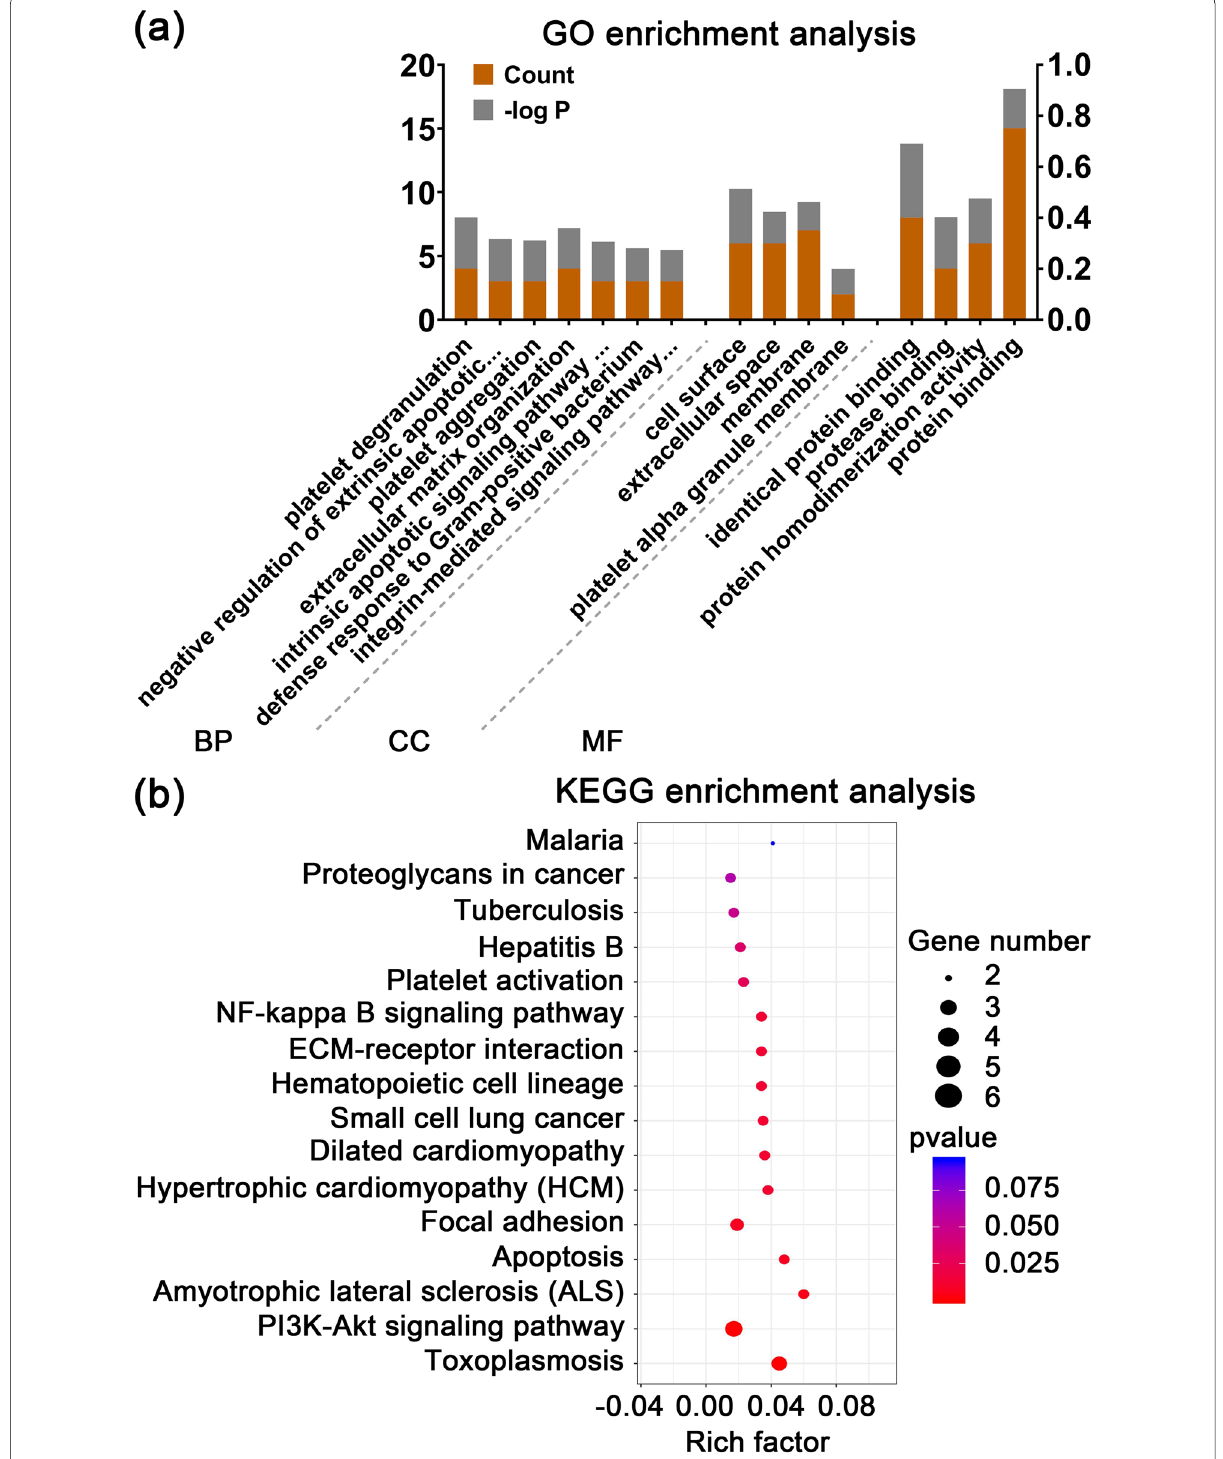
Fig. 5 GO and KEGG enrichment analysis of the core targets of DMAG against thrombocytopenia. a GO enrichment analysis. GO annotations based on the three‑dimension terms of biological process (BP), molecular function (MF), and cellular component (CC). The orange histogram reflects the magnitude of the p value (expressed as log p). The gray histogram shows the number of genes. b KEGG pathway enrichment analysis for − the mechanisms of DMAG against thrombocytopenia. A larger richness factor reflects greater enrichment. The size of the bubble represents the number of genes enriched in the different pathways. The colour of the bubble indicates the range of p